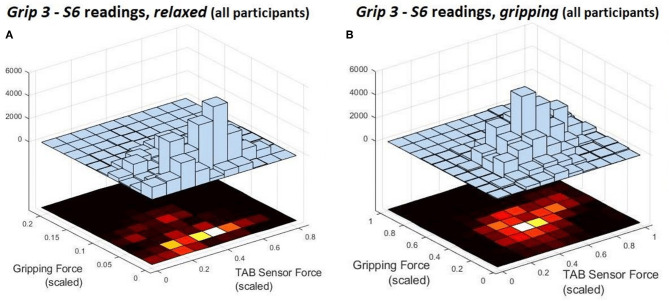
These are the deconstruction of a single histogram from Figure 5. They present the force distribution of the S6 data against the gripping force recorded during Grip3 when the hand is (A)
relaxed and (B)
gripping.